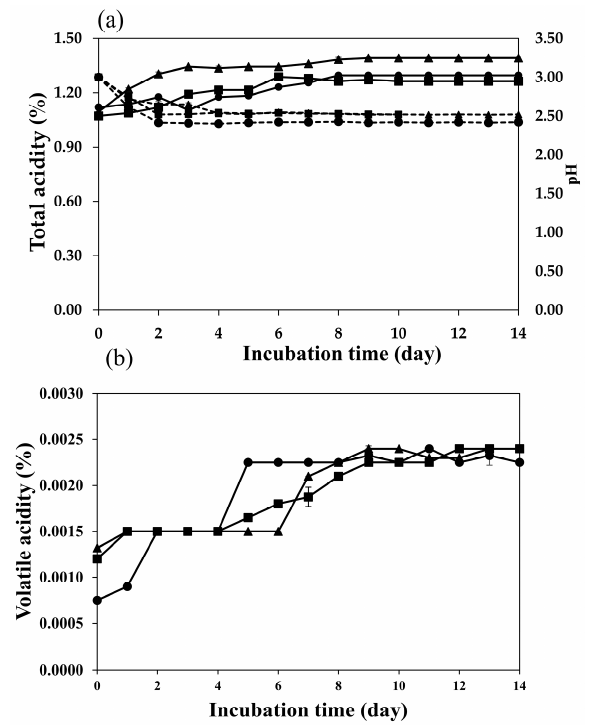
Figure 1. Total acidity (%) (solid line), pH (dash line), ( a ) and volatile acid content ( b ) of plum wine during wine fermentation using S. cerevisiae var. burgundy ( • ), H. thailandica Zal1 ( (cid:4) ), and EC1118 ( (cid:78) ).